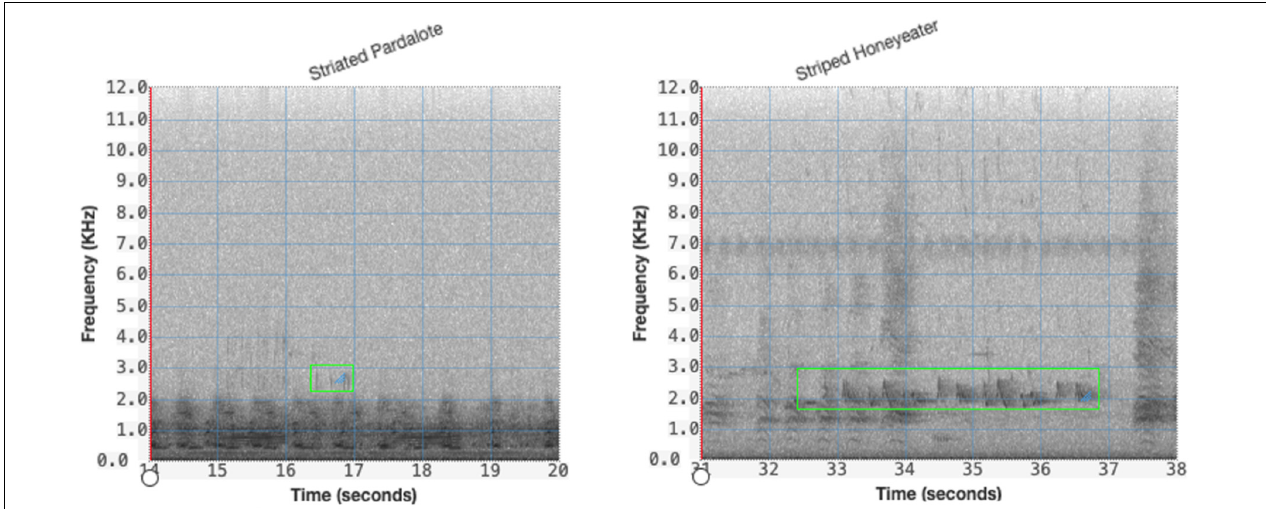
FIGURE 4 | Segmentation of variable length audio, for both short (left) and long (right) annotations showing green bounding box of the time and frequency limits of the